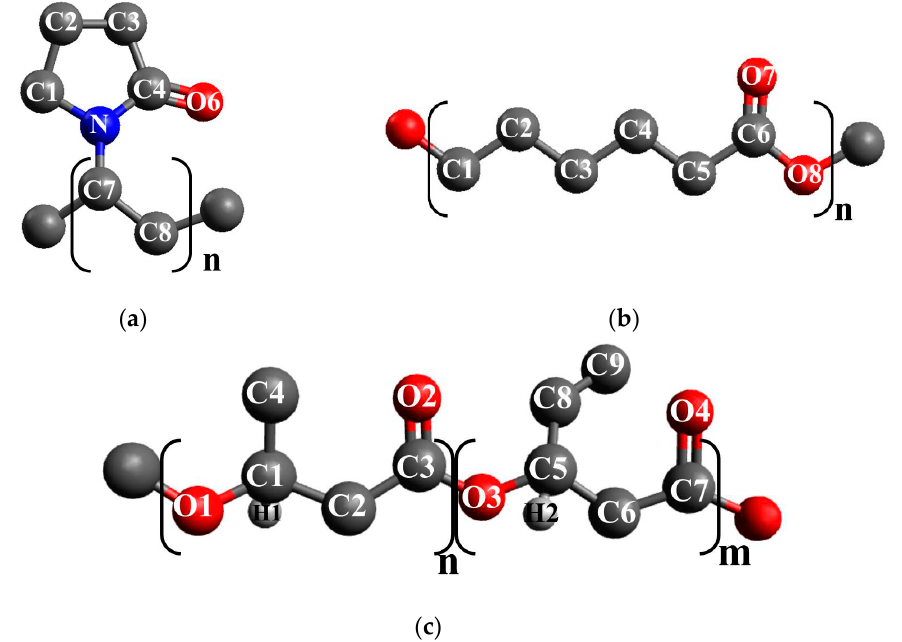
Figure 1. ( a ) Monomer units of PVP, ( b ) PCL, and ( c ) PHBV with atom designations.